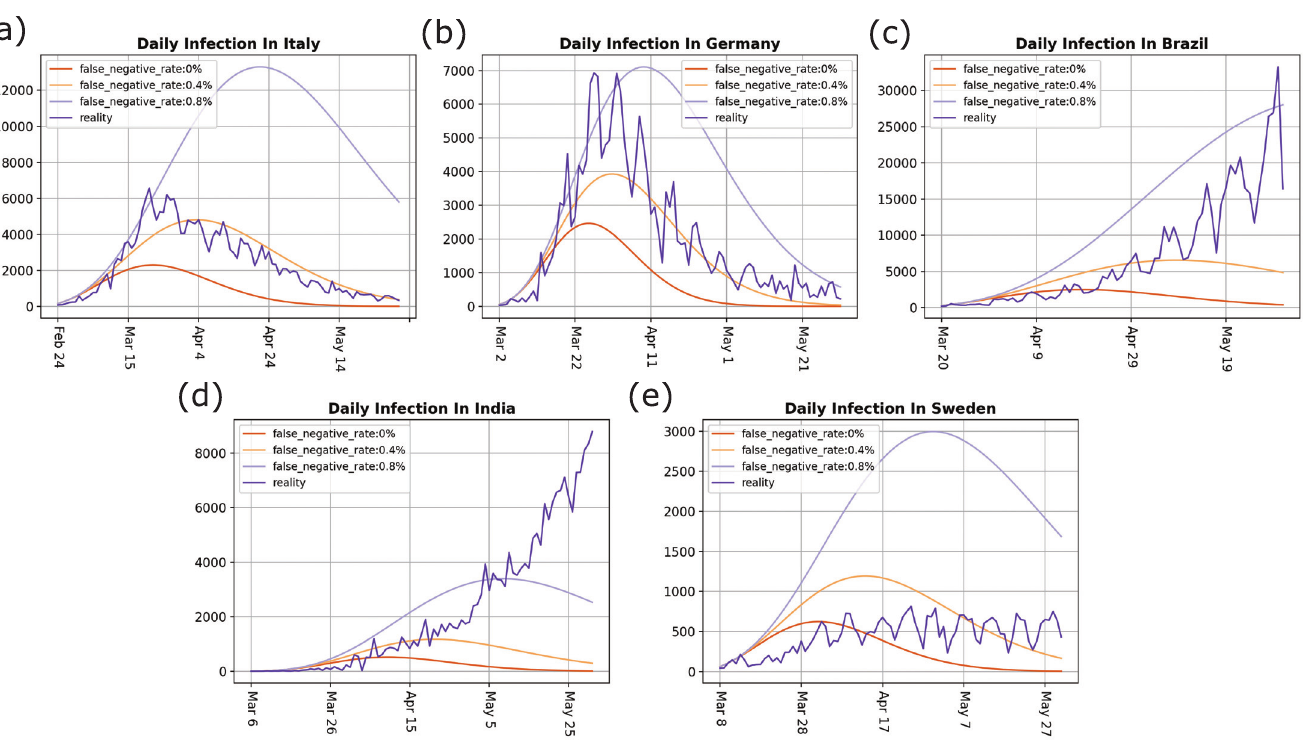
Fig 3. Daily infections. (a) daily infections in Italy, (b) daily infections in Germany, (c) daily infections in Brazil, (d) daily infections in India, and (e) daily infections in Sweden. The red curve describes the daily infections in the real world, and the other curves are the simulated daily infections.